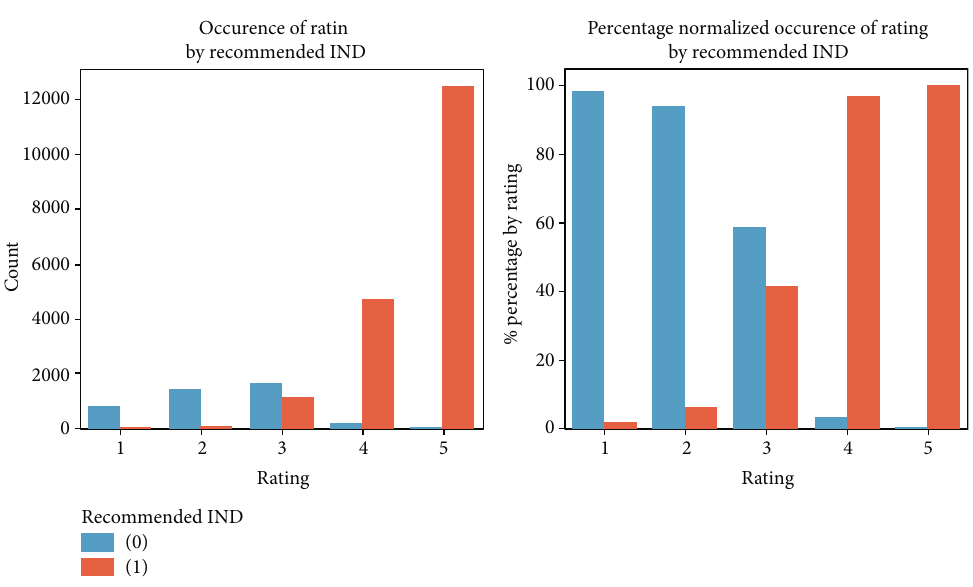
Figure 17: A review rating expresses the recommendation